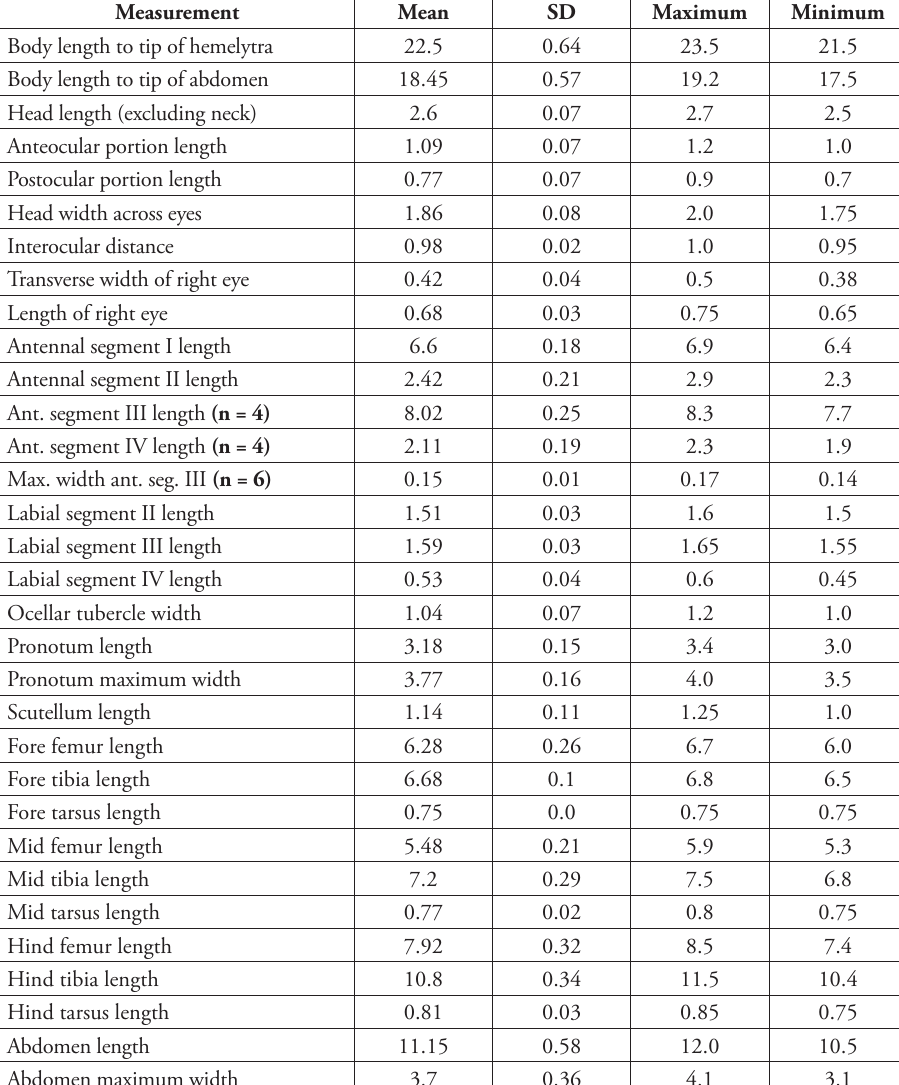
Table 2. Measurements (mm) of female specimens (N = 7) of P. salgadoi from São Paulo State.